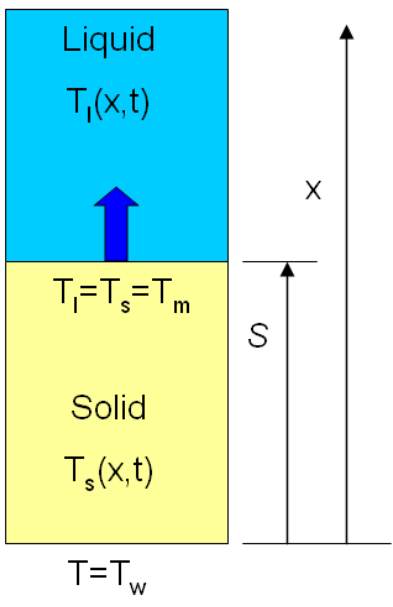
Figure 2. Ice freezing with a moving solidification